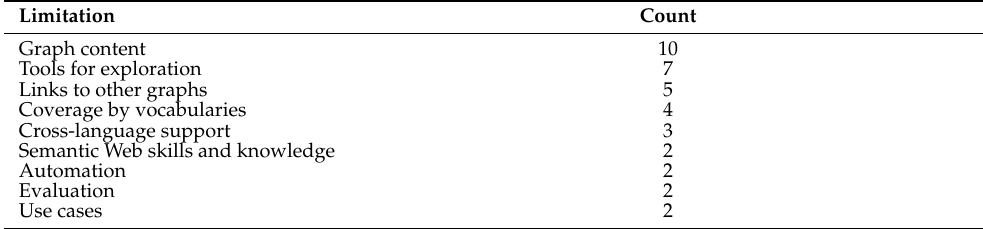
Table 6. Reported